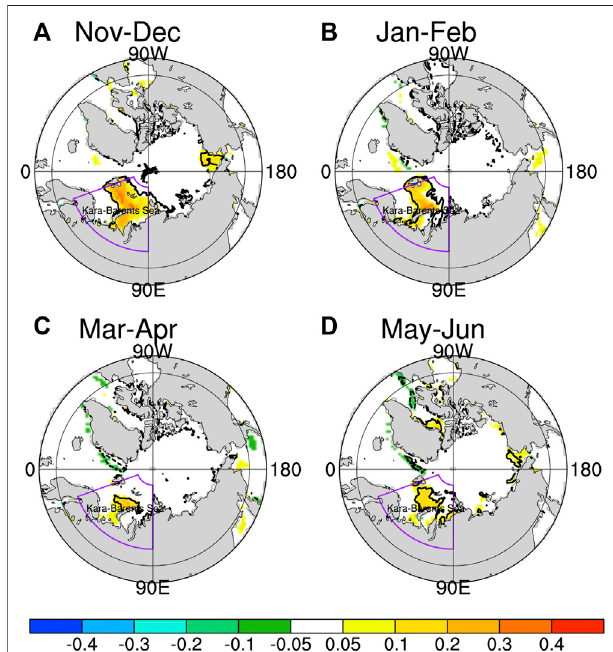
FIGURE 7 | Evolution of regressed Arctic sea ice concentration anomalies (units: dimensionless) from (A – D) November – December to May – June against the standardized November – December mean Arctic sea ice concentration in Barents – Kara Seas as marked in the purple sector. The black contours show the regression at the 95% con fi dence